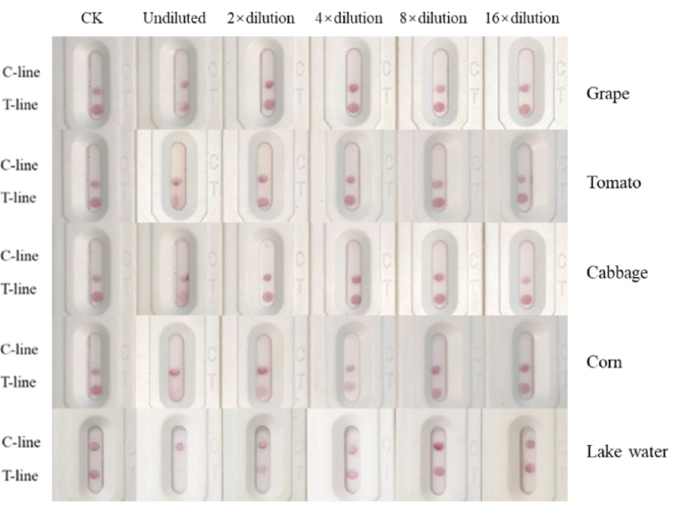
Figure 6. Effects of grape matrix, tomato matrix, cabbage matrix, corn matrix and river water matrix on test paper performance.